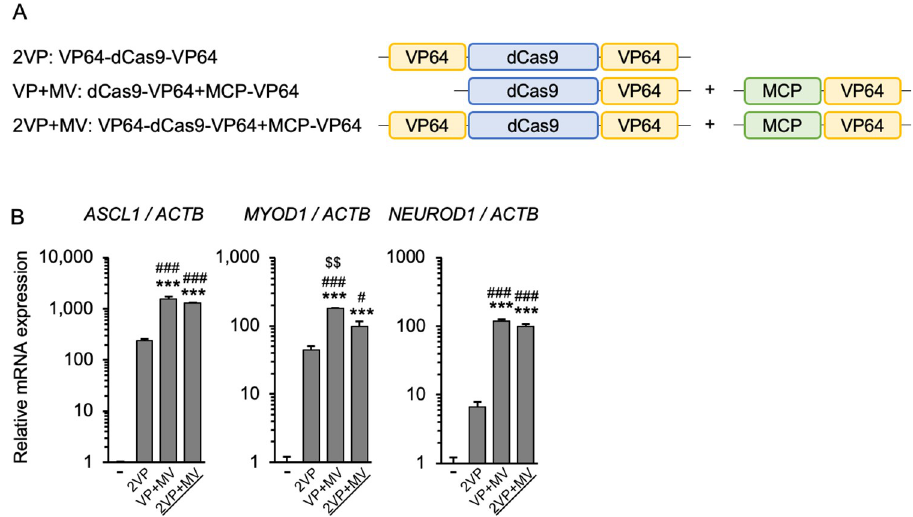
Fig 2. Analysis of CRISPRa-VP64 with addition of N-terminal VP64. (A) Schematic diagrams of the CRISPRa- VP64 systems tested; 2VP+MV is novel. (B) RNA expression of three endogenous genes was assayed in human HEK293T cells expressing the different CRISPRa systems. VP+MV showed the highest activity. Error bars indicate the mean ± SE (n = 3). Statistical analysis was performed using one-way ANOVA with Tukey’s multiple comparisons test. ��� , P < 0.005 vs. non-induced control, # , P < 0.05; ### , P < 0.005 vs. 2VP, $$ , P < 0.01 vs.